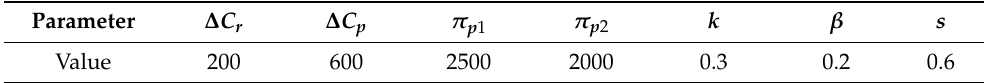
Table 21. Simulation parameter